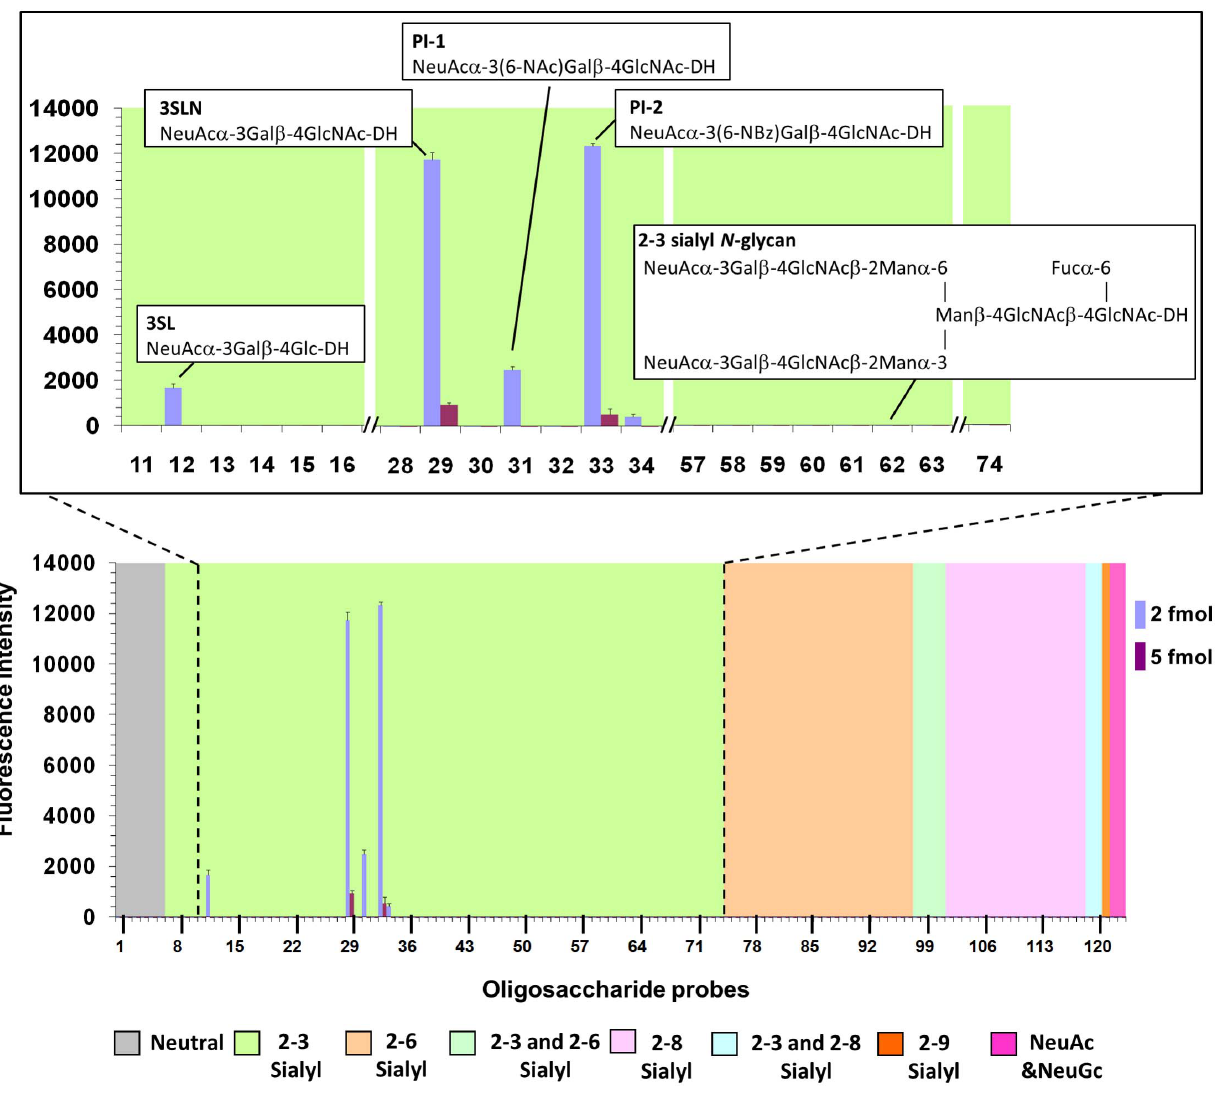
Figure 1. Glycan microarray screening analysis of LPyV VP1 pentamers. Glycan microarray analysis of LPyV VP1 showing selective binding to the short 3SL and 3SLN-related trisaccharide probes with ring-opened flexible cores but not to the N -glycan probe with 3SLN-terminating antennae, complex gangliosides, nor to any of the 6SL and 6SLN-related probes. Numerical scores for the binding intensity are shown as means of fluorescence intensities of duplicate spots at 2 and 5 fmol/spot. Error bars represent half of the difference between the two values. The microarrays consisted of lipid-linked oligosaccharide probes and the sequences are listed in Table S1. The probes are arranged according to terminal sialic acid linkage, oligosaccharide backbone chain length and sequence. The various types of terminal sialic acid linkage are indicated by the colored panels as defined at the bottom of the figure. The expanded region of the microarray highlights the sequences of the probes bound and the selective binding of LPyV VP1 to 3SL and 3SLN-related trisaccharide